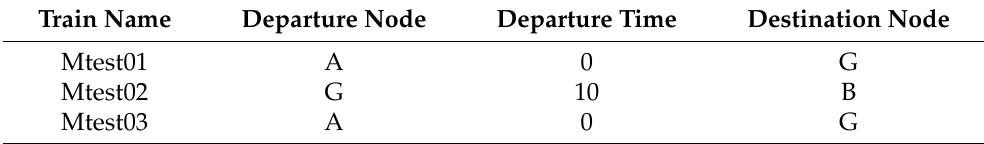
Table 7. Case 4: Train